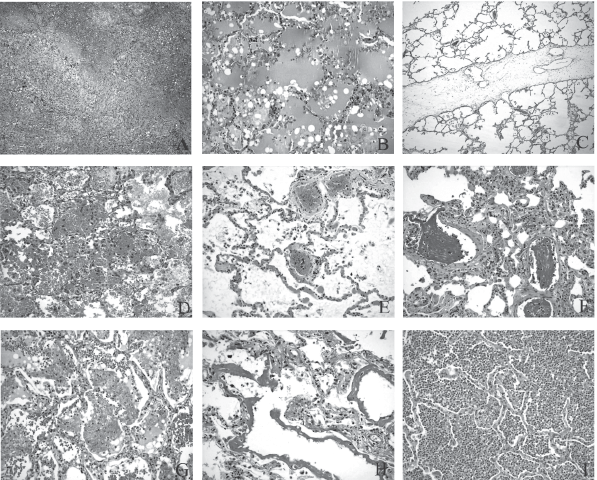
Figure 2 - A (HE, 100X): parenchymal necrosis; B (HE, 200X): alveolar edema; C (HE, 100X): peripheral interstitium edema; D (HE, 200X): alveolar hemorrhage; E (HE, 200X): microvascular congestion; F (HE, 200X): acute vascular thrombosis; G (HE, 200X): alveolar fibrin deposition; H (HE, 200X): hialine membranes; I (HE, 200X): neutrophilic filling of alveolar spaces